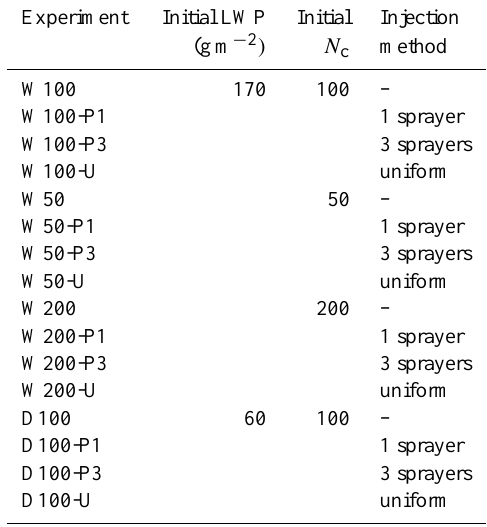
Table 1. Summary of numerical experiments; dry (D) and wet (W) conditions refer to DYCOMS-II RF01 and RF02 sounding respec- tively; note that the units of mg − 1 for CCN number concentra- tion N c are equivalent to cm − 3 when the air density is 1 kgm − 3 . “One sprayer” sails along x -direction at the center of y -direction ( y =30km) at 5ms − 1 , and “three sprayers” are 20-km apart. “Uni- form” means that particles are injected from the entire surface area